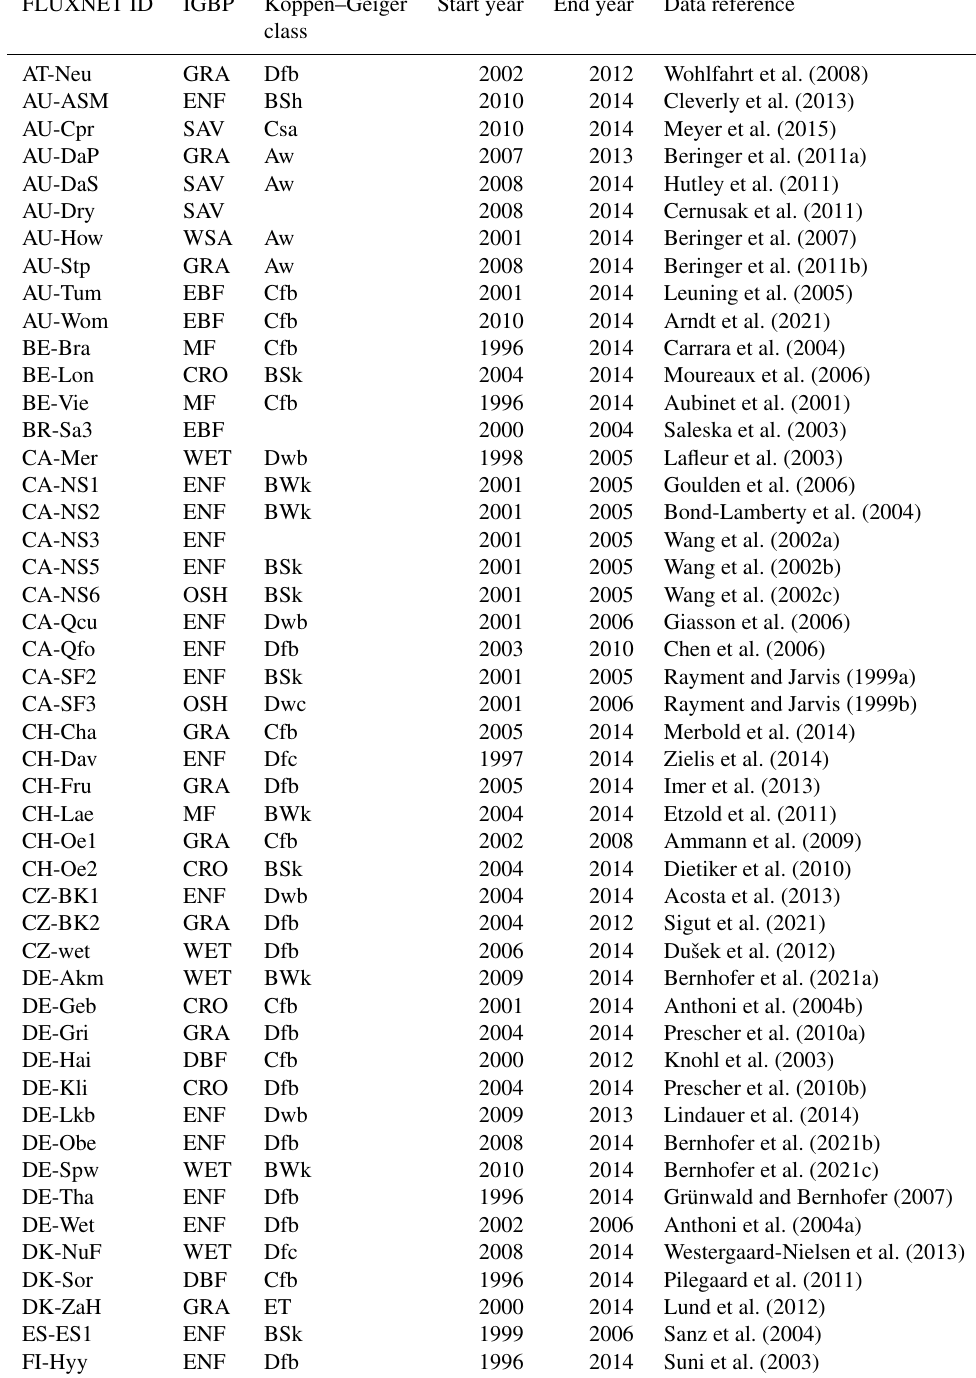
Table A1. List of FLUXNET sites used for the generation of artificial datasets and the time period used. IGBP: International Geosphere– Biosphere Programme. DBF: deciduous broadleaf forest; OSH: open shrubland; WET: wetland; CRO: cropland; CSH: closed shrubland; MF: mixed forest; EBF: evergreen broadleaf forest; WSA: woody savanna; SAV: savanna; ENF: evergreen needleleaf forest; GRA: